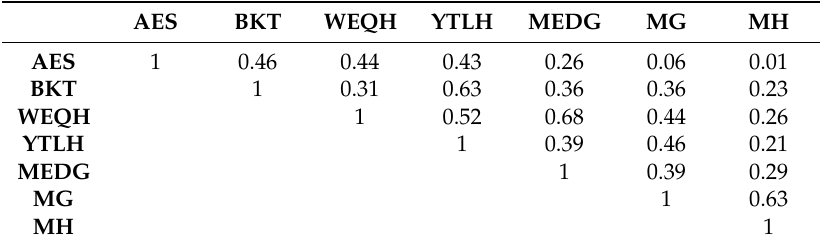
Table 3. Correlation matrix for the standard ring-width chronologies for the seven sampling sites, 1960–2013 (all values significant at p <